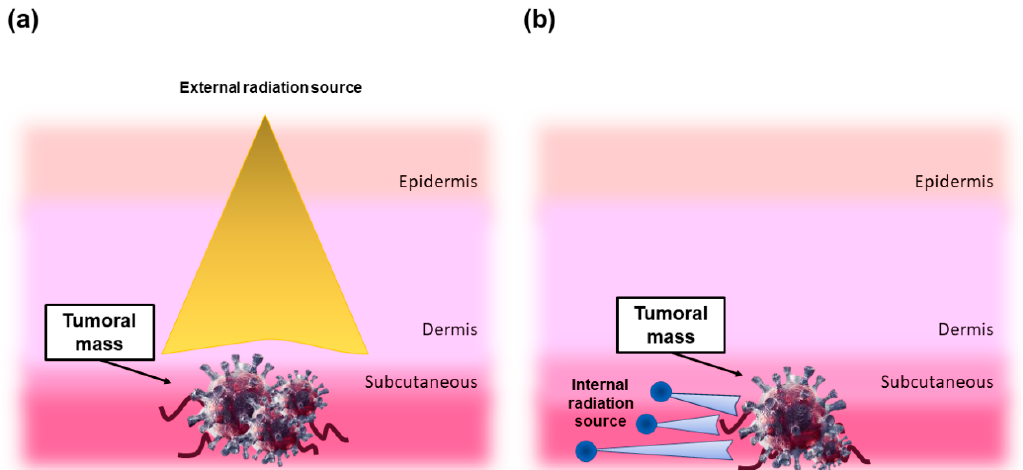
Figure 1. Principles of radiation therapy. ( a ) Scheme demonstrating tissue absorption of external beam radiation: the radiation emitted damages both tumor and healthy cells through electron excitation and release of energy. ( b ) The concept behind brachytherapy: radioactive seeds (blue spheres) emit beta and/or gamma rays into the target tumor.